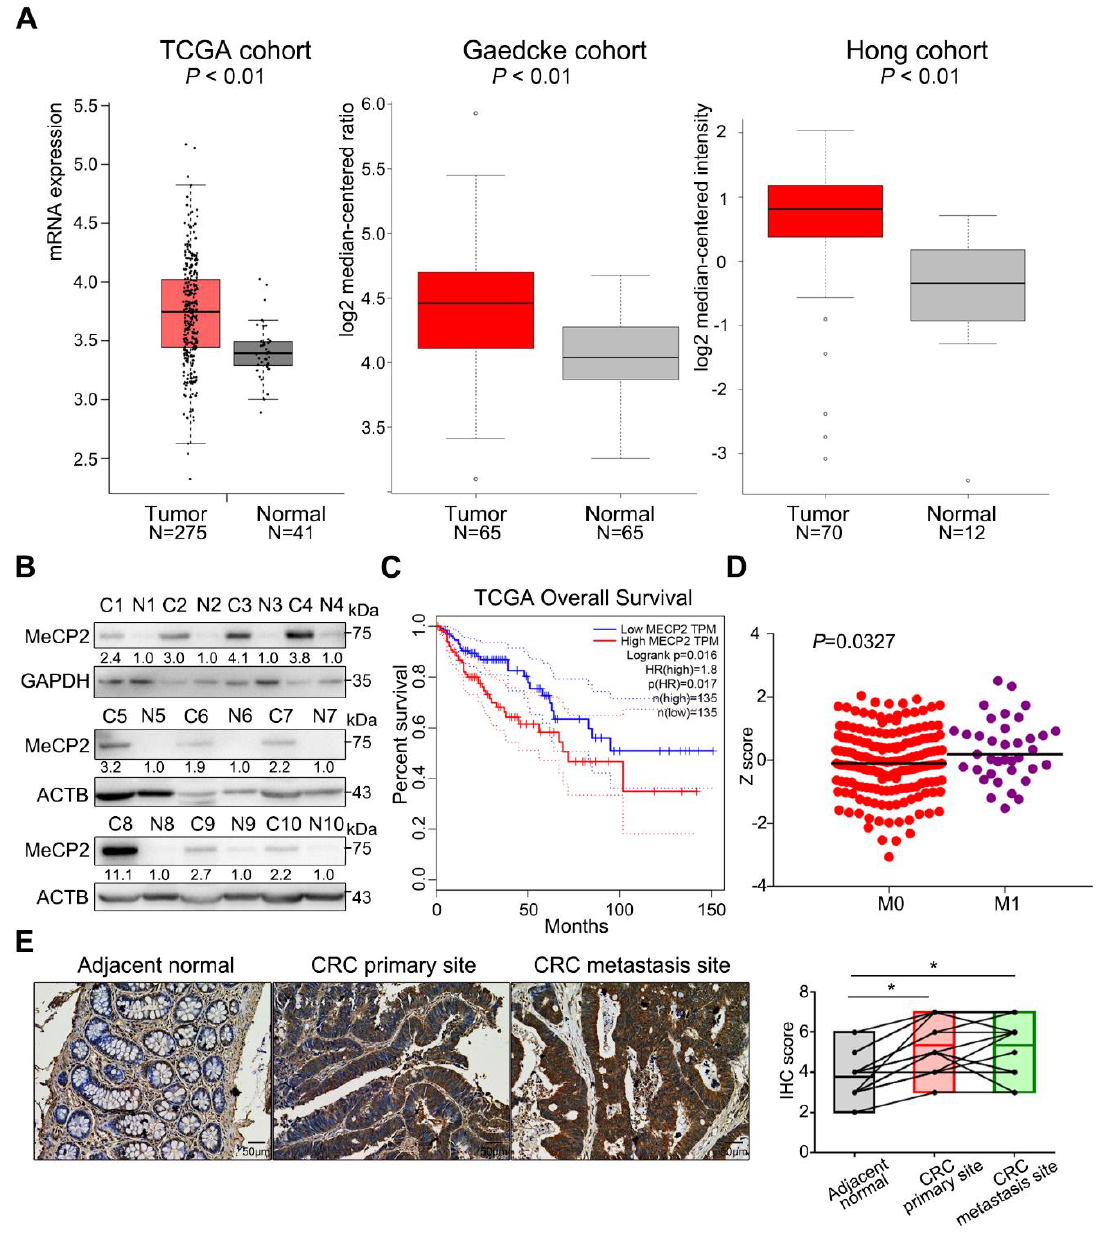
Figure 1. MeCP2 is overexpressed in metastatic colorectal cancer (CRC). ( A ) MeCP2 mRNA is upregulated in CRC tissues compared to normal tissues in the Cancer Genome Atlas (TCGA) cohort (left), and the Oncomine (Gaedcke and Hong) cohorts. ( B ) MeCP2 protein expression is higher in CRC tissues compared to adjacent normal tissues, as determined by Western blot. ( C ) Correlation between MeCP2 expression and survival in TCGA database for CRC, analyzed with the Gene Expression Profiling Interactive Analysis (GEPIA) online analysis tool (Kaplan—Meier analysis of Overall Survival time). HR, hazard ratio. ( D ) MECP2 mRNA expression is higher in M1 stage CRC patients compared to M0 stage CRC patients. ( E ) MeCP2 immunohistochemistry (IHC) staining scores in paired adjacent normal, CRC tumor tissues, and liver metastasis tissues ( n = 15).